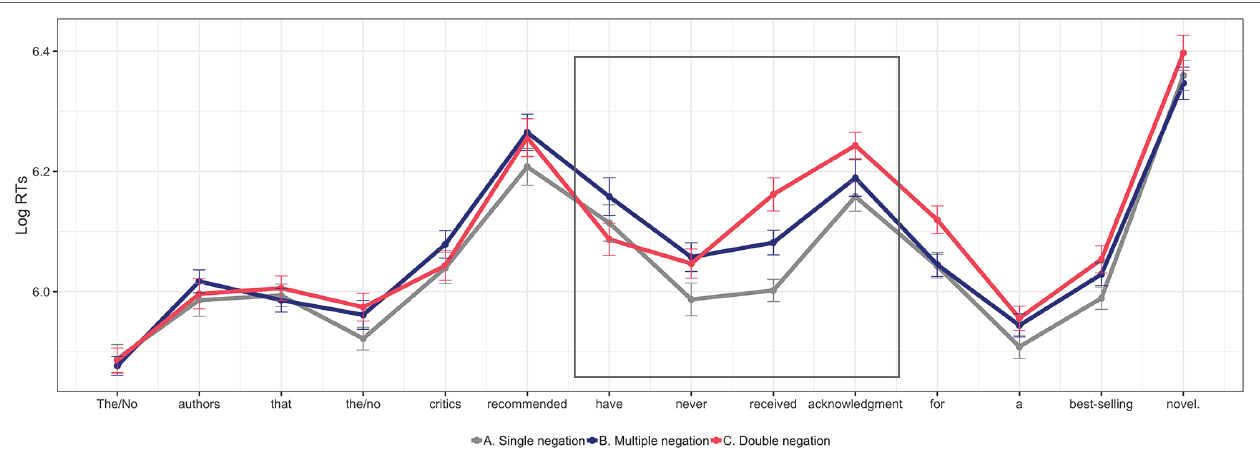
FIGURE 2 | Average word-by-word reading times for the experimental conditions aggregated by participant (Experiment 2). Error bars indicate standard error of the mean. The regions of interest are contained within the